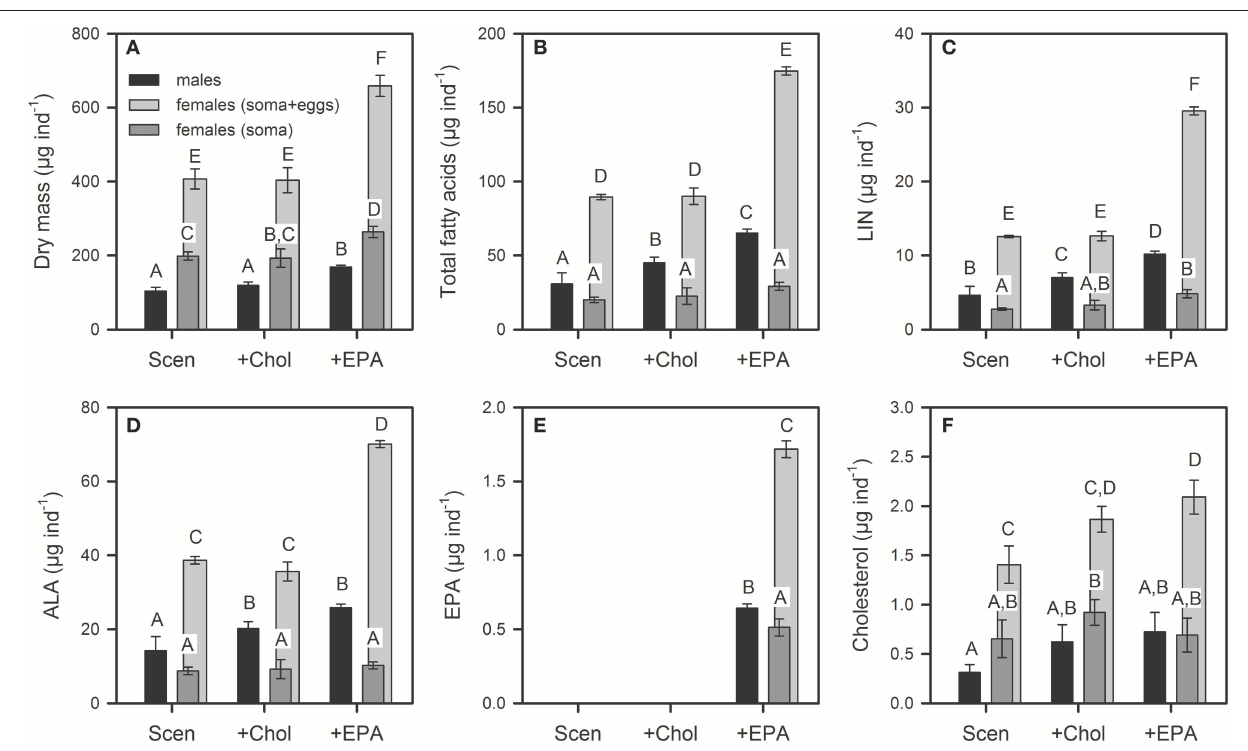
FIGURE 6 | Dry mass (A) , total fatty acid (B) , linoleic acid (LIN; C) , α -linolenic acid (ALA; D) , eicosapentaenoic acid (EPA; E) , and cholesterol (F) content ( µ g individual − 1 ) of male and female somata of D. magna reared on S. obliquus (Scen) and S. obliquus supplemented with cholesterol or EPA until females deposited their third-clutch eggs into their brood chambers. Female somata and eggs produced in the first three reproduction cycles were analyzed separately to assess biomass and lipid allocation into female reproduction. Light gray bars (soma + eggs) represent the dry mass and lipid content of female somata at the end of the experiment figured up with the cumulative dry mass and lipid content of eggs produced within the first three reproduction cycles. Dry mass data represent means of n = 6 ± SD; lipid data represent means of n = 3 ± SD. Data points labeled with the same letters are not significantly different (Tukey’s HSD, P < 0.05, following ANOVA; Table